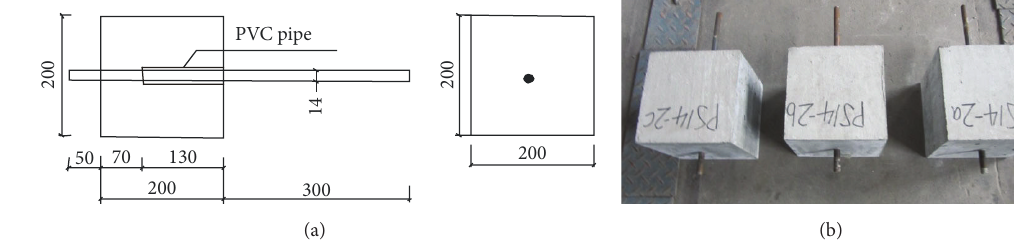
Figure 1: Pullout specimen: (a) schematic diagram and (b) picture of real products.